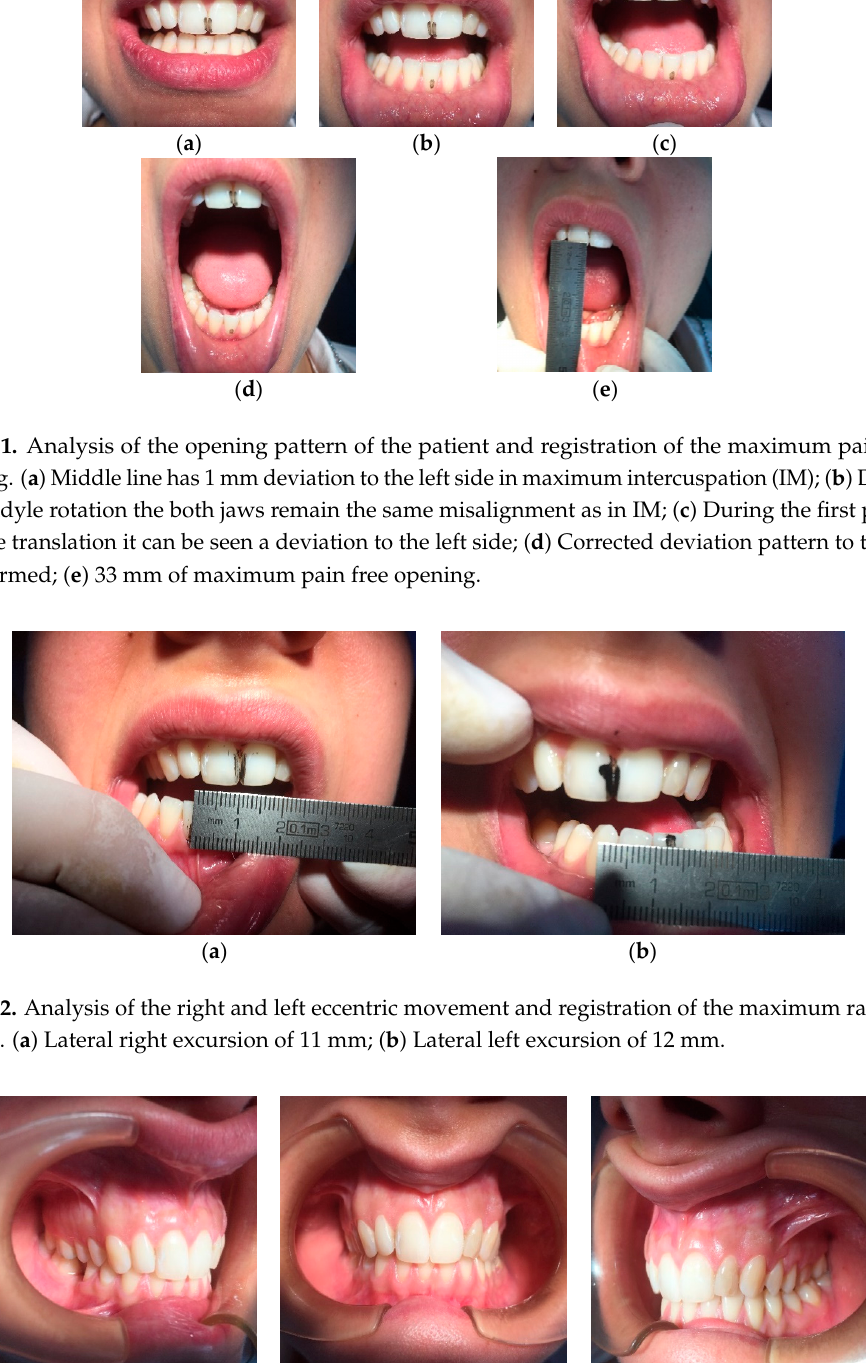
Figure 3. Occlusal analysis, ( a ) lateral right, ( b ) frontal and ( c ) lateral left pictures in maximum intercuspation.